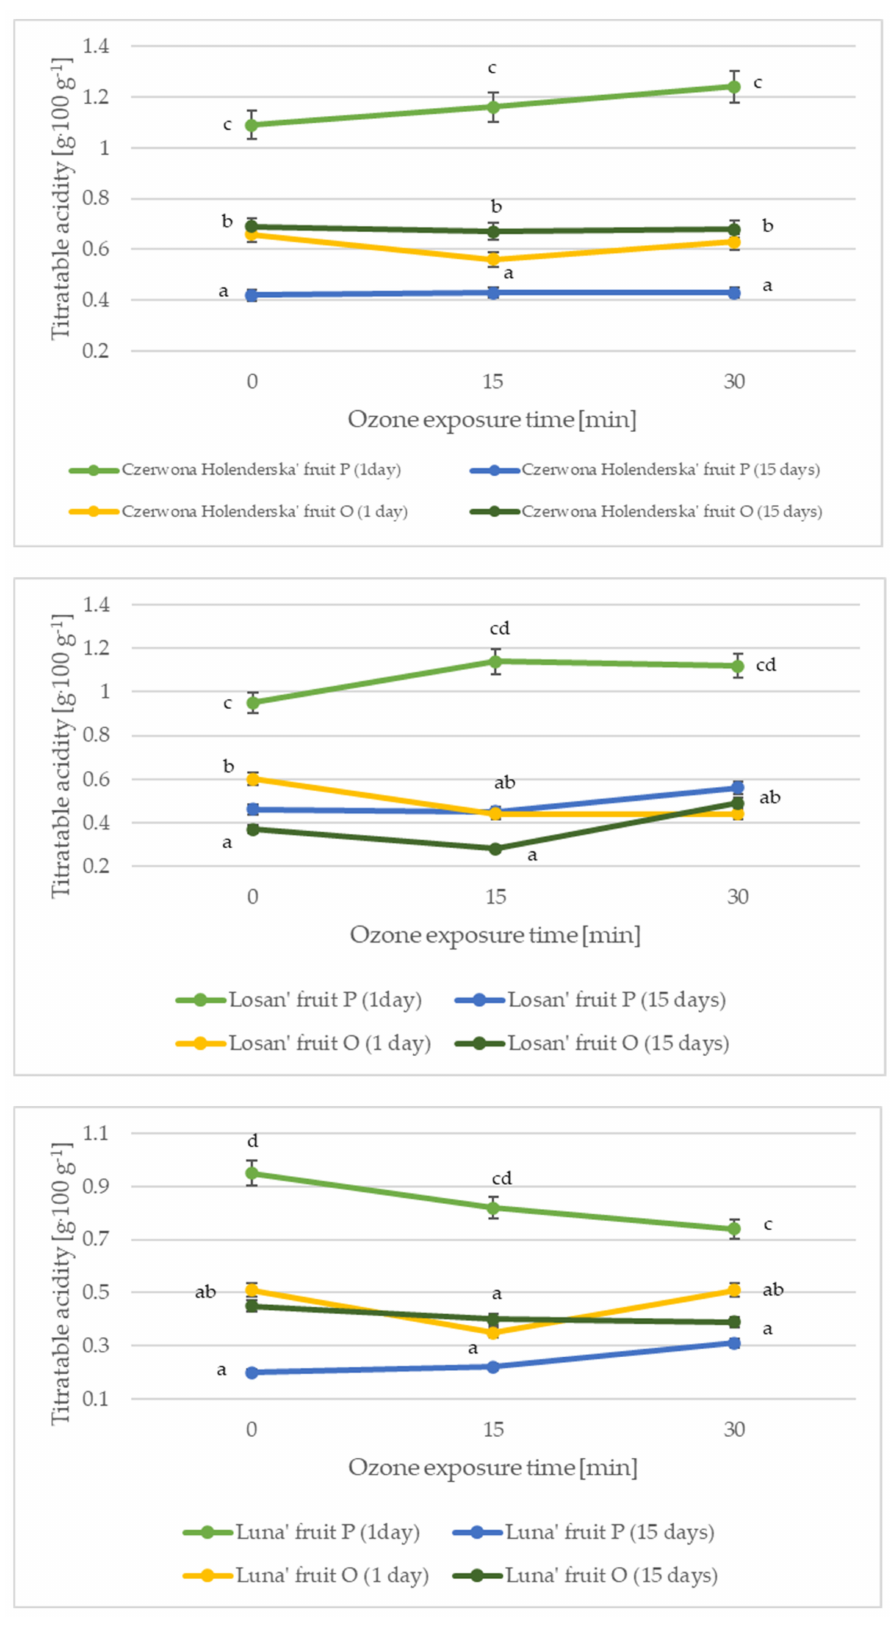
Figure 3. Changes in the acidity of red currant fruit depending on the harvest date, variety, and ozone exposure time. Data are expressed as mean values (n = 3) ± SD; SD—standard deviation. Mean values with different letters are significantly different ( p <